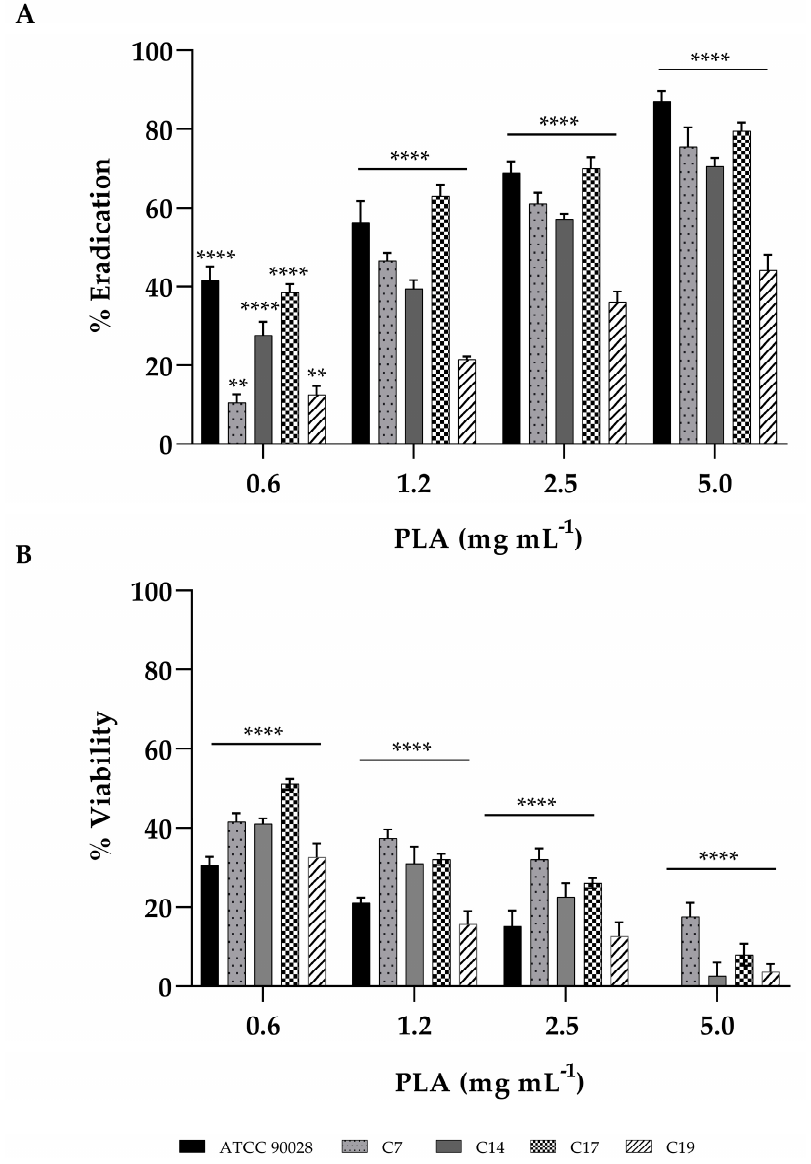
Figure 4. Eradication of pre-formed biofilm by PLA at concentrations of 0.6, 1.25, 2.5, and 5 mg mL − 1 against C. albicans ATCC90028 and clinical isolates C7, C14, C17, and C19. Two different methodol-